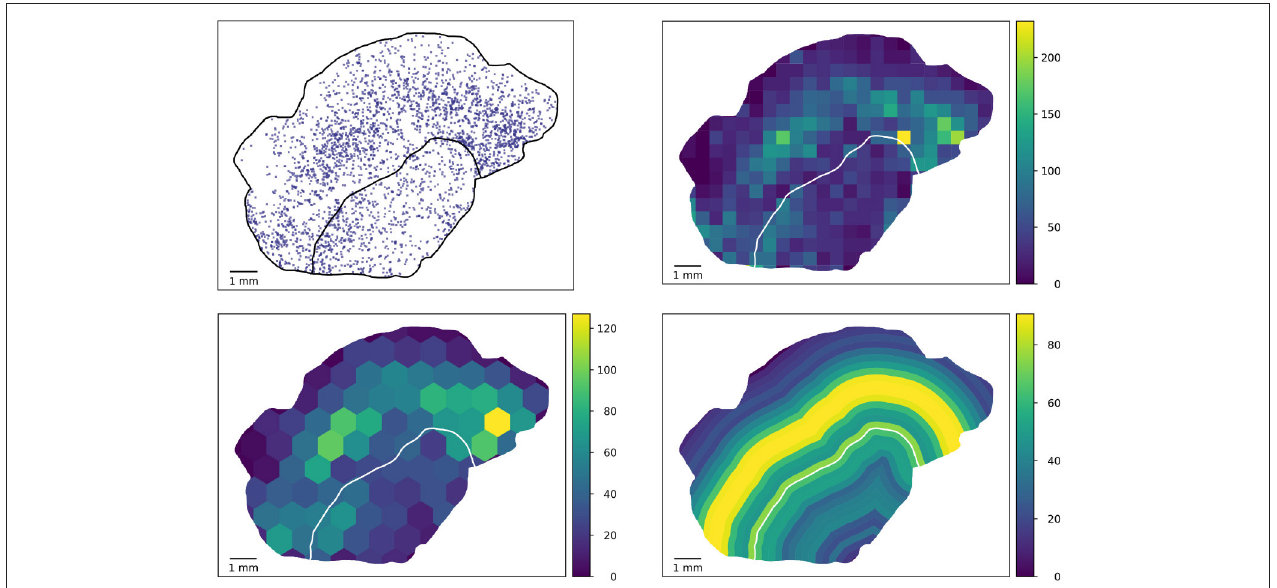
FIGURE 7 | Potential extension of the tile-based analysis. Densities of proliferating CD8 objects (top left) can be computed in generic tiles, e.g., geometrically defined squares (top right) used in this study, hexagons (bottom left, mock-up), or biologically motivated equidistant rings at the tumor boundary (bottom